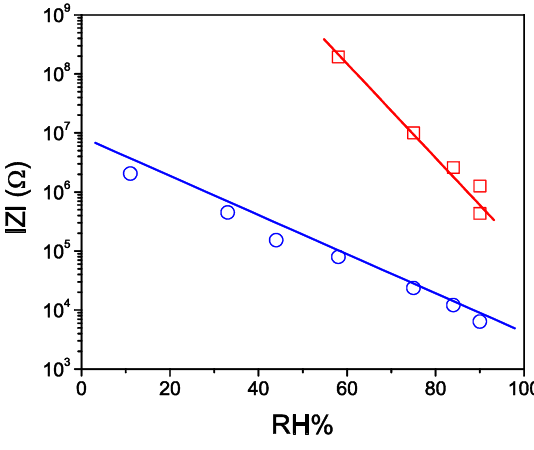
Figure 5. Dependence of the logarithm of impedance modulus from the relative humidity of films 9SPC (red squares) and 18SPC (blue circles) at 25 Hz and 200 Hz, respectively. The solid lines correspond to the